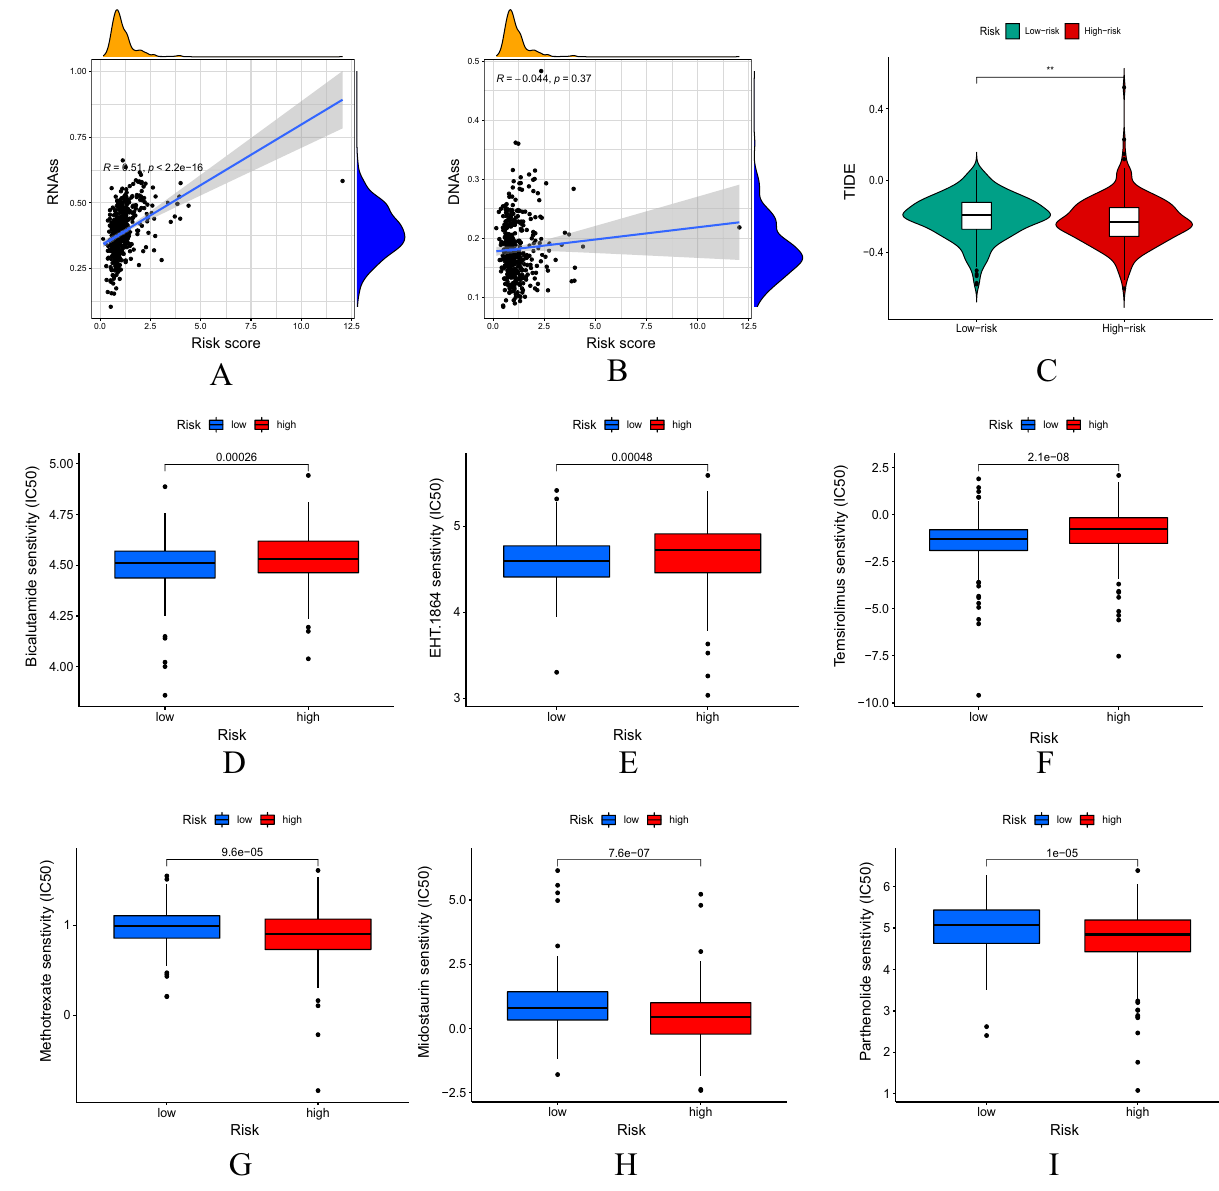
Figure 10. The risk score model is closely related to stem cells, TIDE scores and drug sensitivity. Correlation between the risk scores with RNAss ( A ) and DNAss ( B ) stem cells. ( C ) Differential expression of TIDE scores between the low and the high risk groups. ( D–I ) Drug sensitivity analysis of two risk